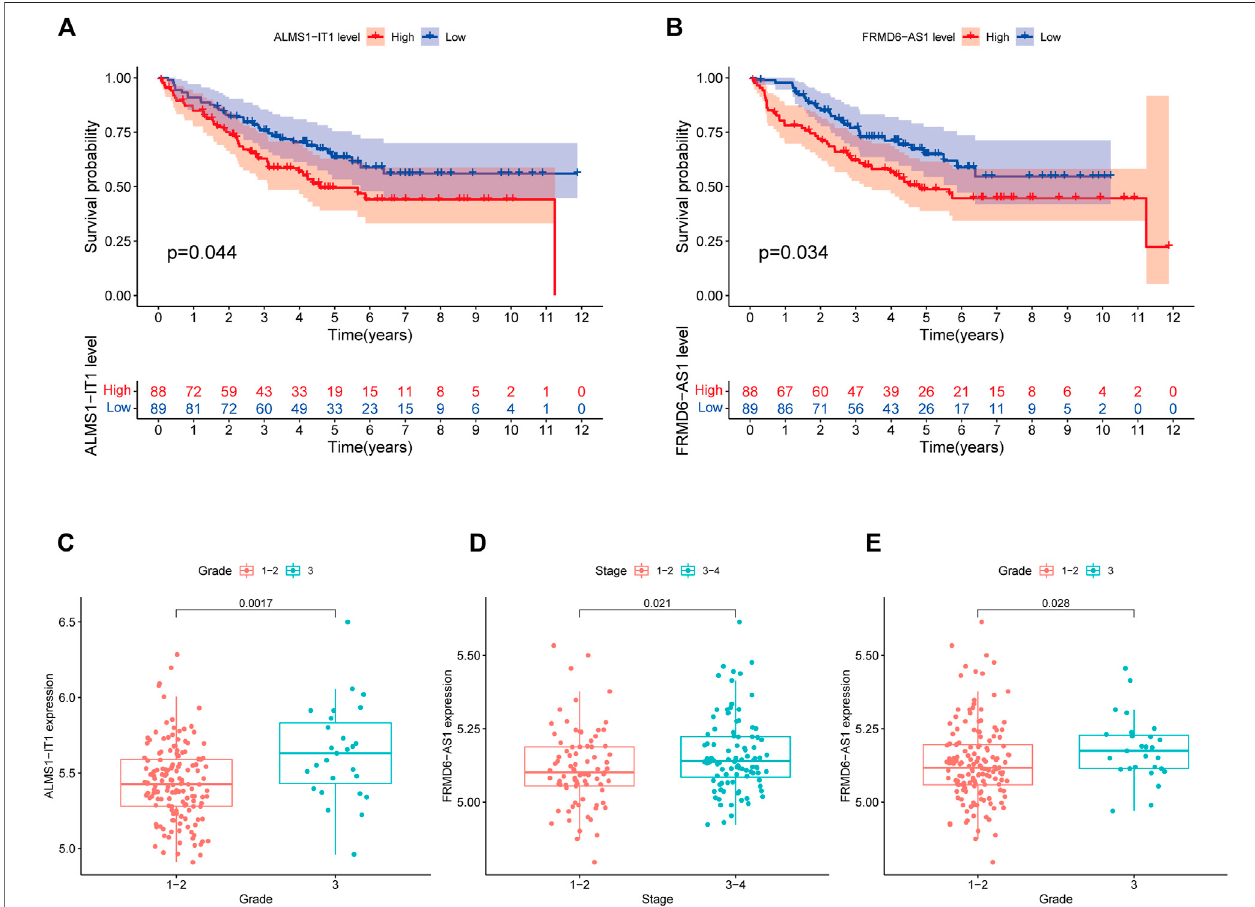
FIGURE 7 | Validation of lncRNA prognostic signatures in the GEO cohort. (A) Kaplan-Meier survival curve of ALMS1-IT1. (B) Kaplan-Meier survival curves of FRMD6-AS1. (C) CorrelationbetweenALMS1-IT1expressionandgrade. (D) CorrelationbetweenFRMD6-AS1expressionandstage. (E) CorrelationbetweenFRMD6- AS1 expression and